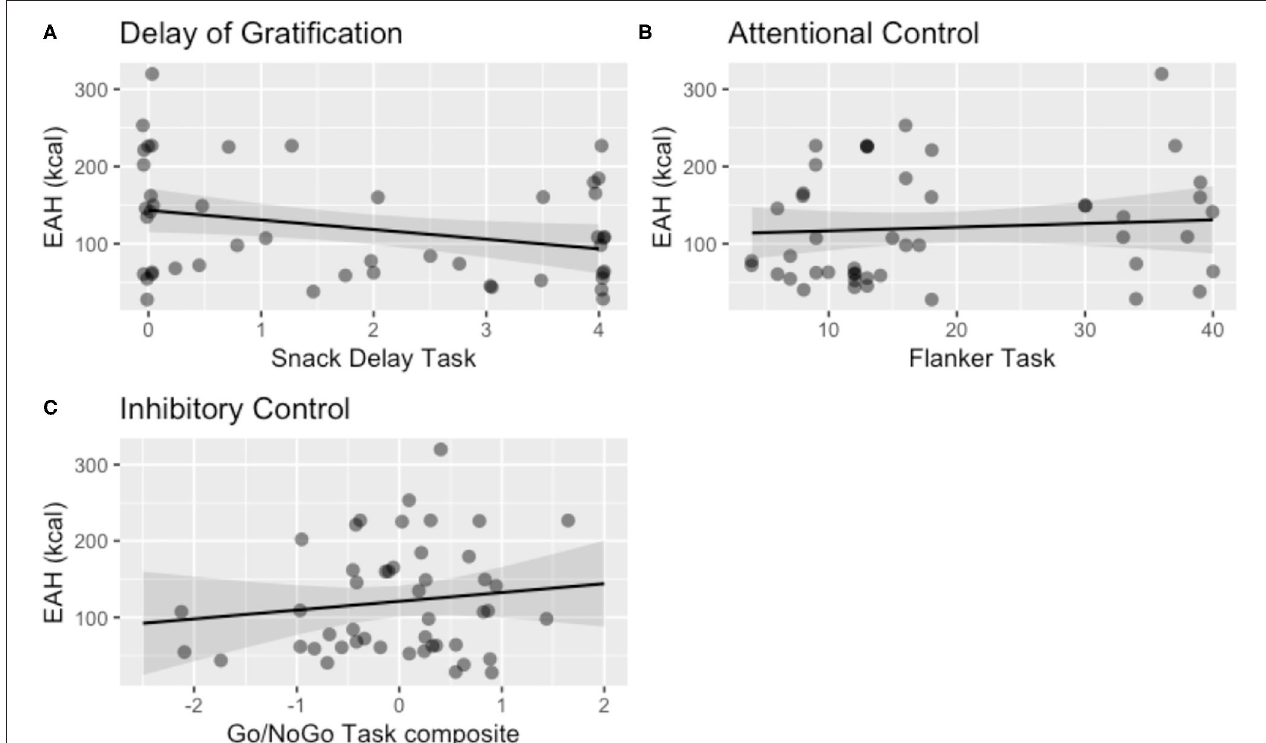
FIGURE 3 | Visualization of the main effect of child self-regulation on eating in the absence of hunger (EAH) controlling for child age, child sex, child BMI, and the number of calories (kcal) consumed during the lunch test meal, in the domains of (A) delay of gratification ( b = − 12.46, p = 0.04), (B) attentional control ( p = 0.67), and (C) inhibitory control ( p = 0.34). One of the multiply imputed data sets was chosen at random for plotting purposes.